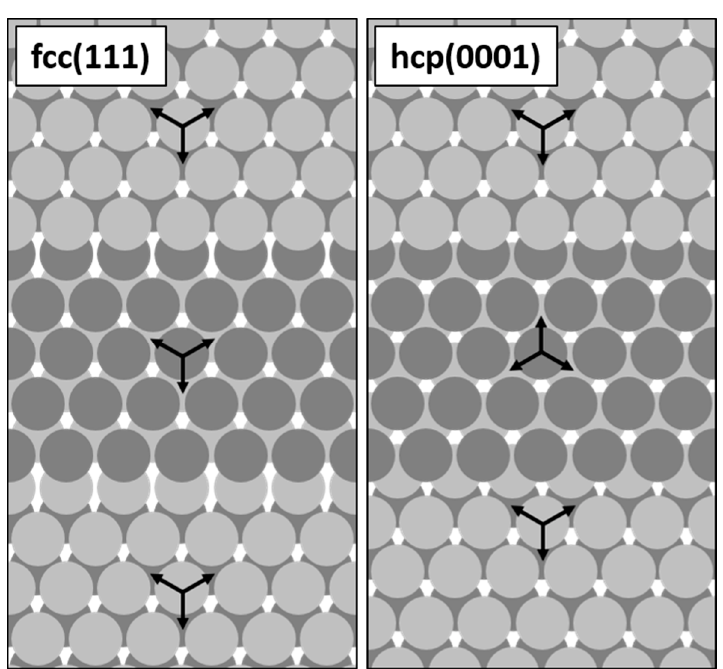
Figure 1. Schematic drawings showing the mutual orientation of adjacent monoatomic terraces on stepped fcc(111) and hcp(0001) surfaces (only the first two atomic layers are shown for each terrace; based on a similar figure published in Reference [10]).